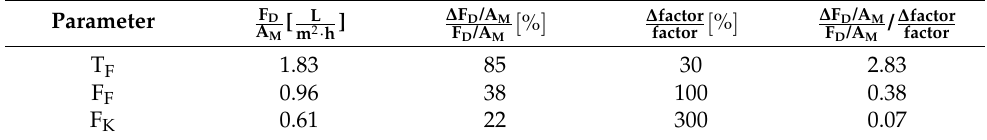
Table 10. Effects of the parameters on the transmembrane distillate flux F D during AGMD.